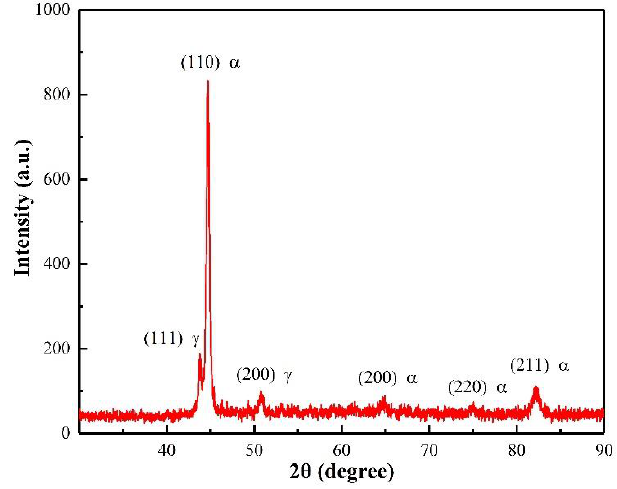
Figure 6. XRD pattern of the WM.